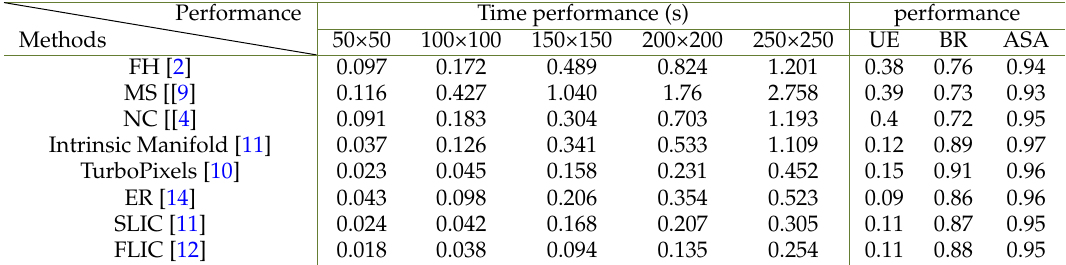
Table 1. Comparison of time performance and performance with different superpixel methods